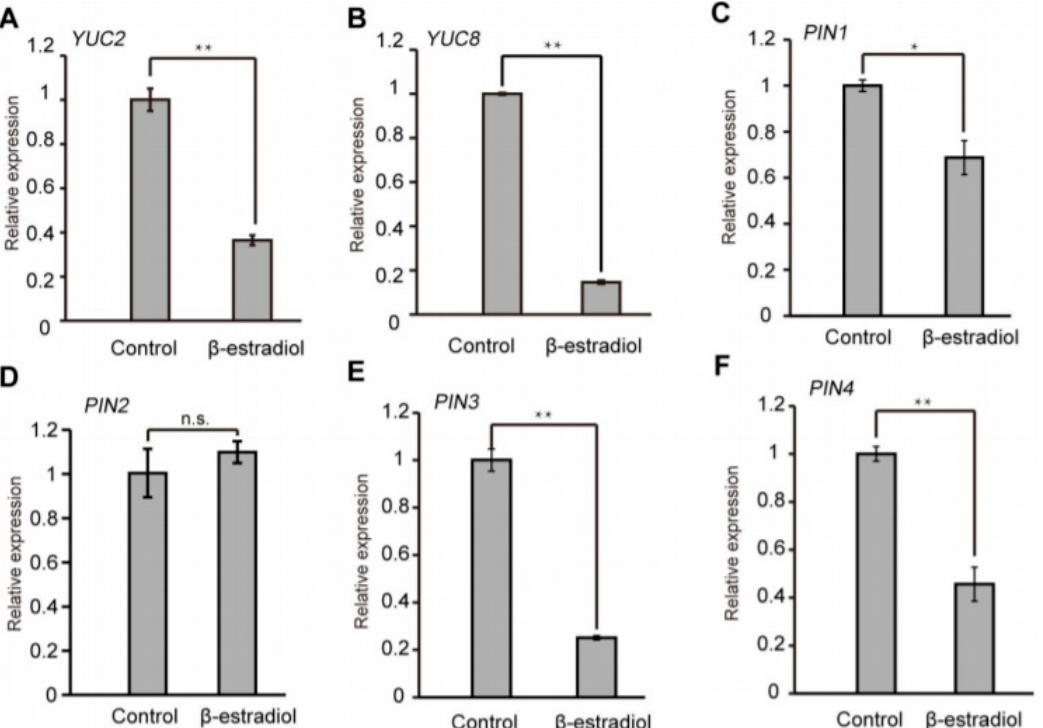
Figure 5. Overexpression of ATHB2 reduced the expression levels of some auxin biosynthetic and transport genes. ( A – F ) Expression patterns of YUC2 , YUC8 and several PINs genes in the iATHB2 transgenic lines . The different 6-day-old iATHB2 transgenic lines were treated with or without 10 μ M β -estradiol for 2 h. The ACTIN7 gene was used as an internal reference. The shown data are results of the representative iATHB2 2# transgenic line. The qRT-PCR results were performed for three biological replications and similar results were observed. Representative qRT-PCR results with three technical replicates were shown. Error bars denote ± SD. * p < 0.05, ** p < 0.01, Student’s t test. No significant difference is shown by n.s.